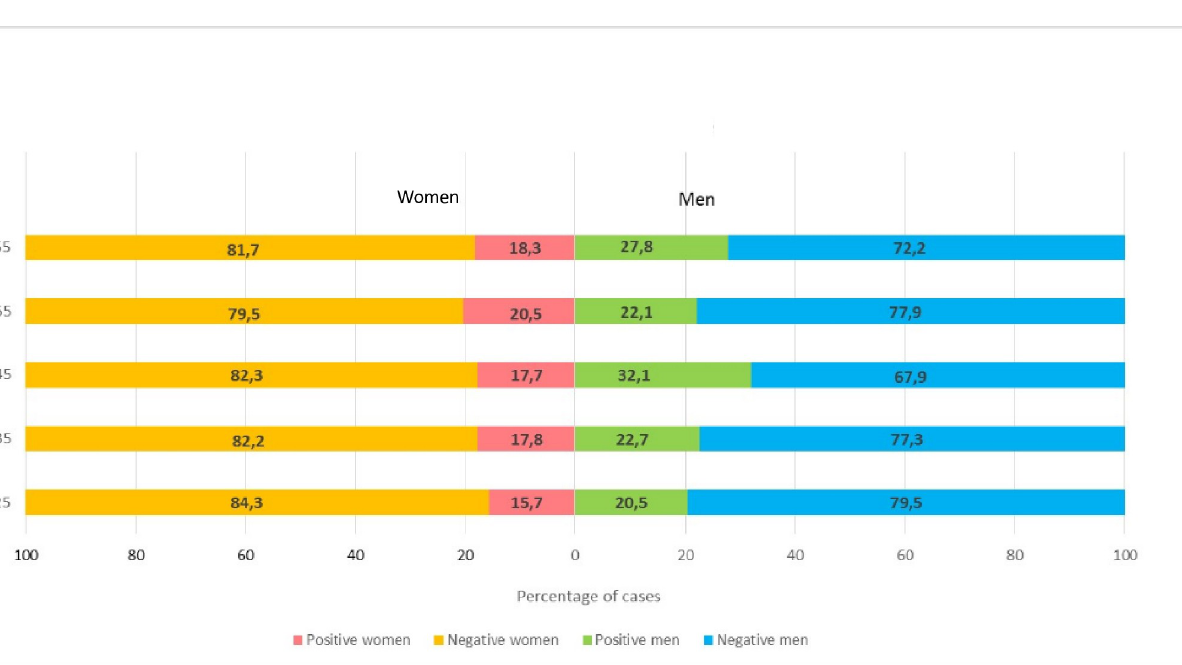
PLOS ONE | https://doi.org/10.1371/journal.pone.0245001 January 14,